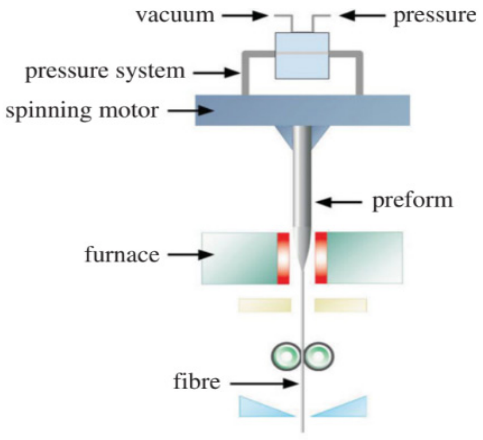
Figure 12. Sketches of the fabrication setup by spinning the fiber preform during the drawing process in the fiber pulling tower. Adapted from Ref. [11].